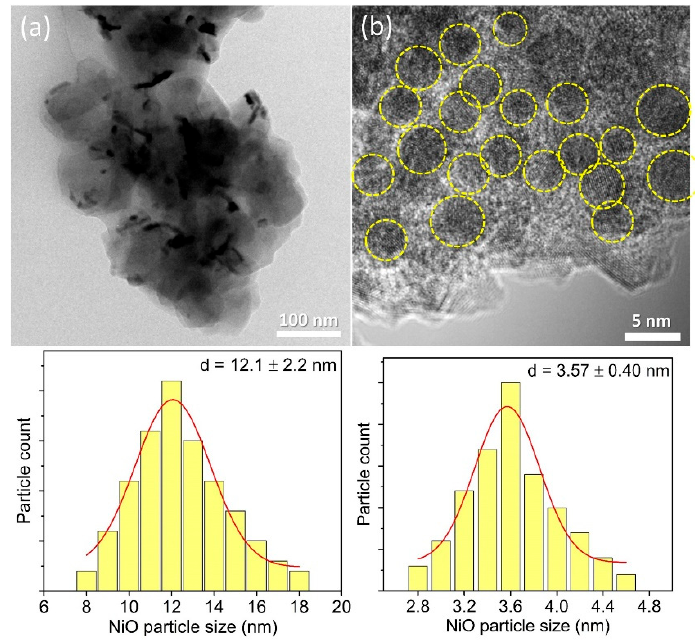
Figure 2. HRTEM images of ( a ) IM-Y65 and ( b ) DP-Y65.